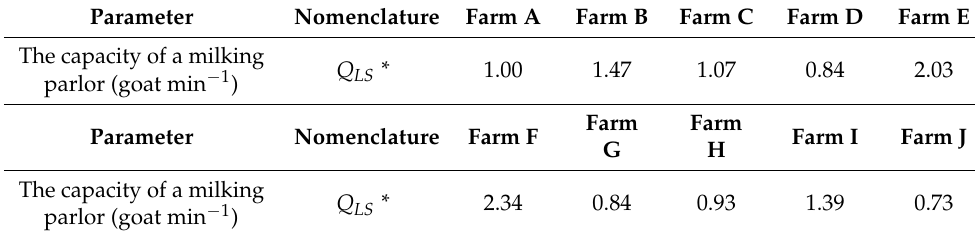
Table 4. The real capacity of milking parlors.